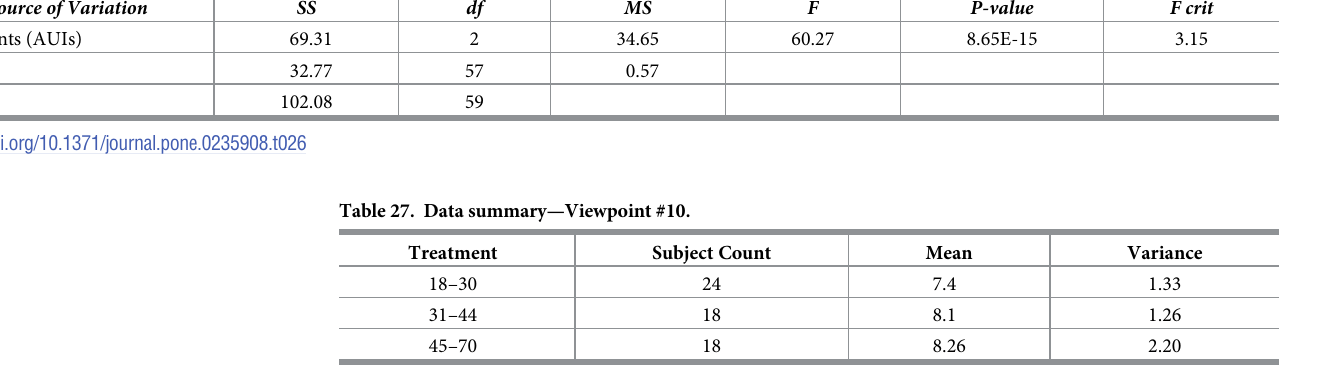
Table 26. One-way ANOVA—Viewpoint #9. Source of Variation